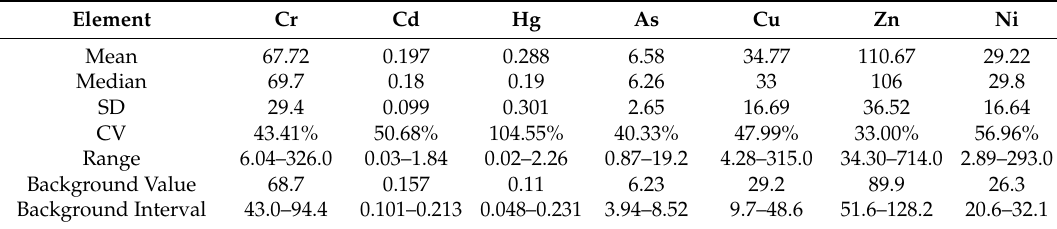
Table 1. Summary statistics for trace elements in topsoil (mg/kg) [43].